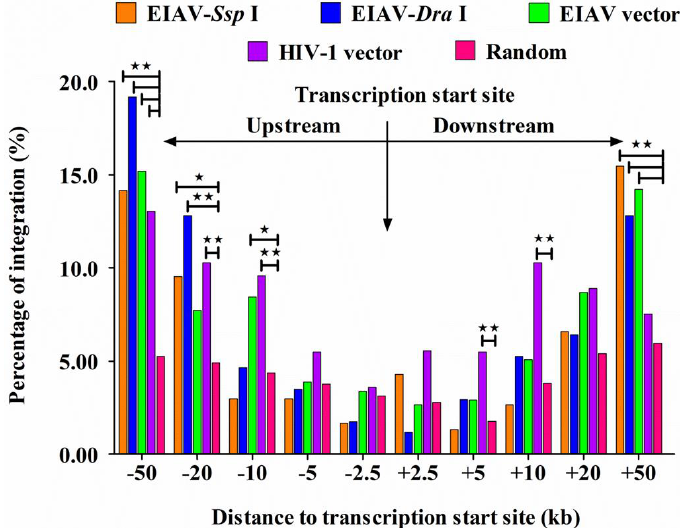
Figure 4. Gene density within a 2 Mb window centered on the insertion site was determined and classified into eight groups (0–10, 11–20, 21–40, 41–60, 61–80, 81–100, 101–120, >120). The percentage of integration within each group was calculated. The number of integration sites analyzed in the Ssp I and Dra I group was based on the horse genome; and the HIV-1 and EIAV vector group was based on the human genome. The chi-squared test was used. * indicates significant, i.e ., p < 0.05; ** indicates very significant, i.e ., p < 0.01.